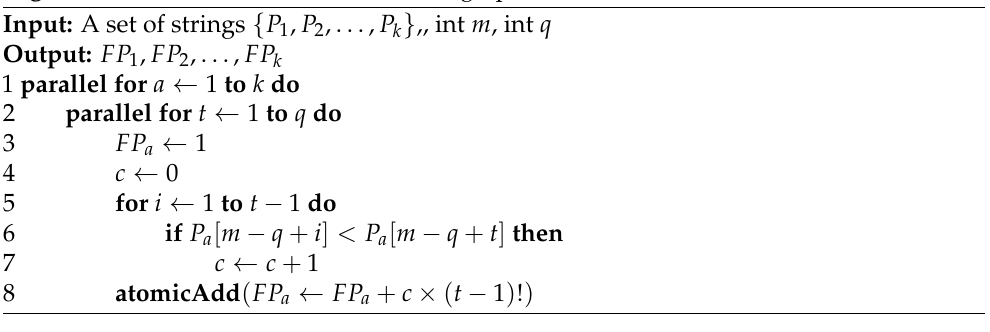
Algorithm 4 The search phase of the algorithm using a fingerprint